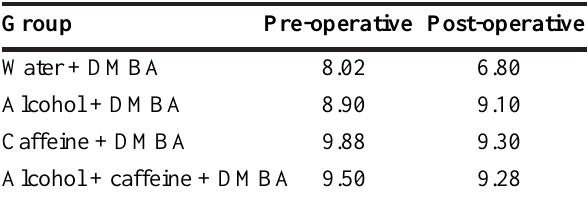
TABLE 2 - Average solution volume (ml) daily